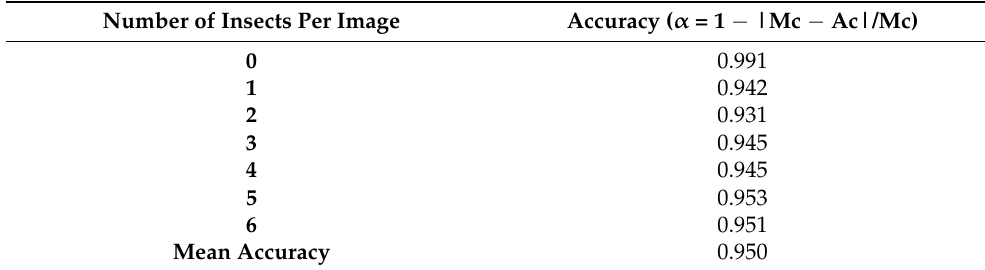
Table 3. Accuracy ( α = 1 − |Mc − Ac|/Mc) as measured per class. Accuracy drops from 99% for the background class to 95% for the 6 insects class. The mean acc. is